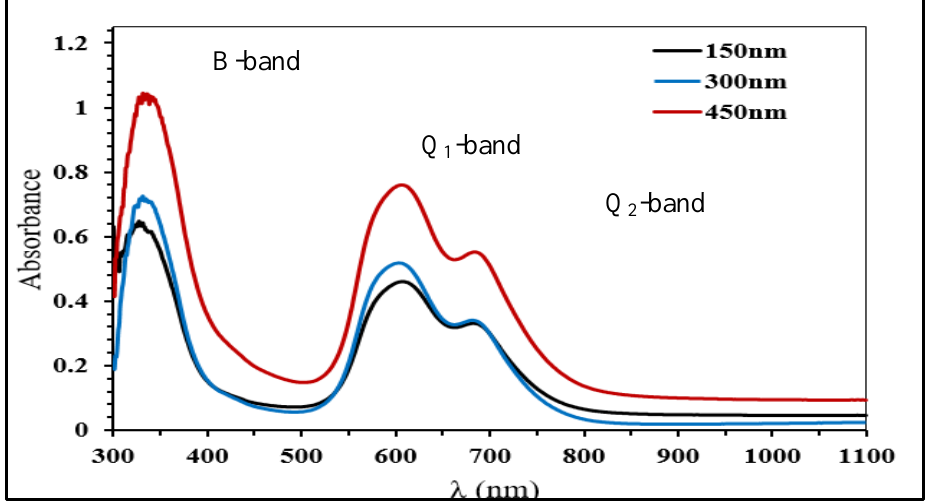
Fig.2: Absorbance as function of wavelength regarding CuPc thin films having various thicknesses at room